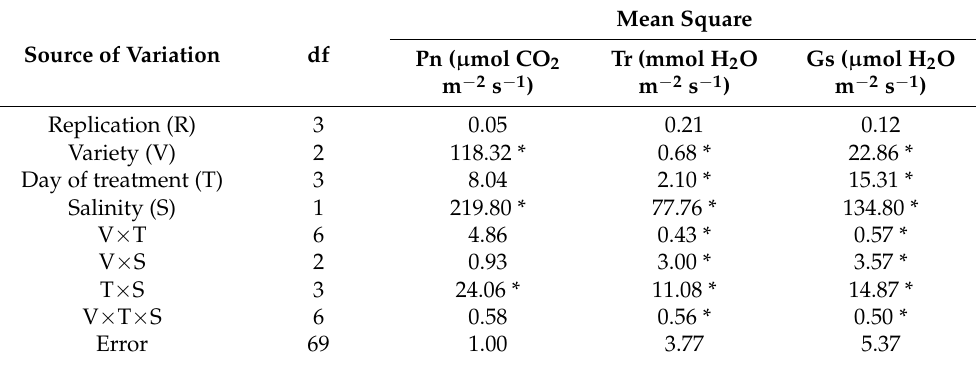
Table 4. ANOVA result of gaseous exchange parameters.